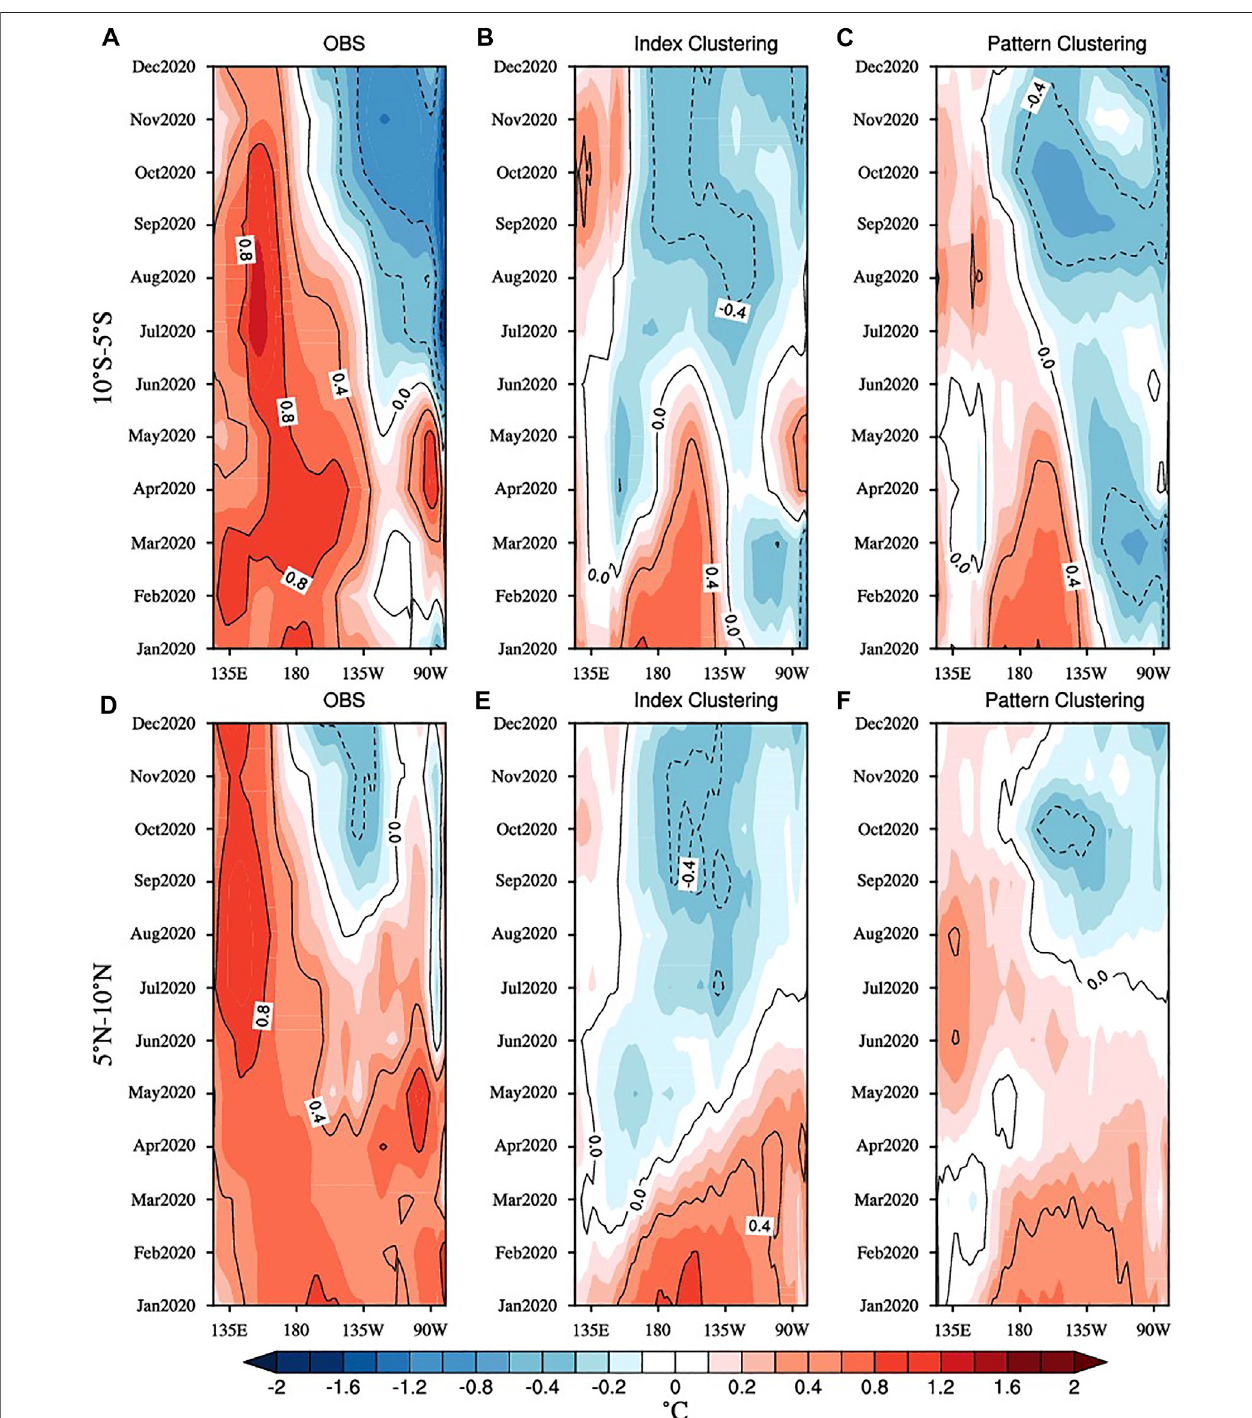
FIGURE 3 | Temporal evolution of the SSTA along the off-equatorial Paci fi c (averaged between 10 ° S and 5 ° S and between 5 ° N and 10 ° N) in 2020 for (A,D) observations, (B,E) the ensemble mean of the best prediction members by index clustering, and (C,F) the ensemble mean of the best prediction members by pattern clustering. The contour interval is 0.4 ° C.